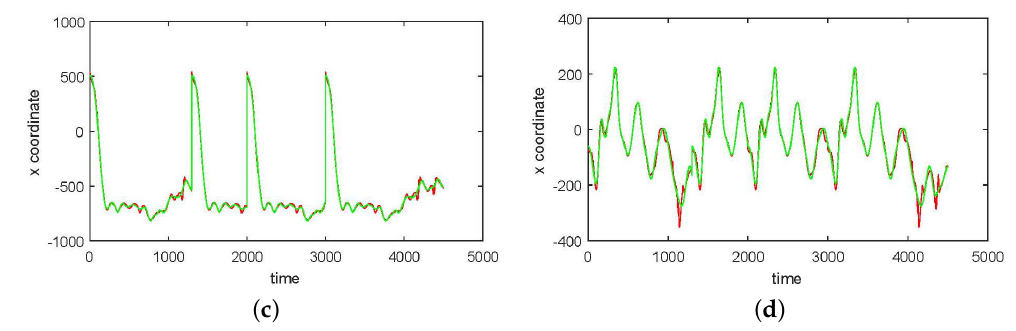
Figure 3. An approximation of x -coordinates by 25 satellites and two centers of motion (CMU 86 Trial 1) consisting of jumping, kicking, and punching (sampled at 120Hz). ( a ) Right heel; ( b ) Left heel; ( c ) Right wrist, distal; ( d ) Left wrist, distal. The red curve shows the experimentally observed coordinates and the green curve gives their neural approximations.